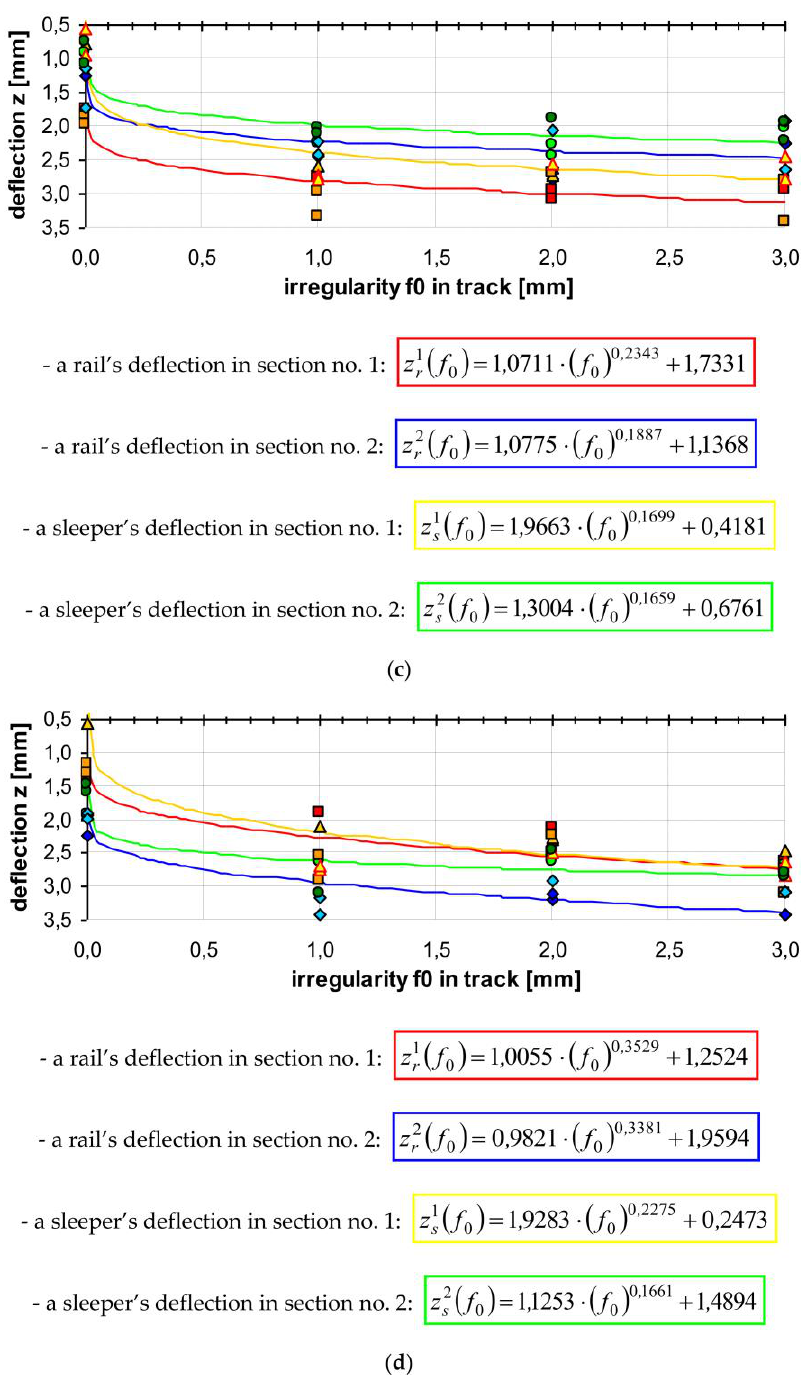
Figure 8. A deflection of the rail and sleeper due to induced irregularity in the railway track (axle load no. 3 and no. 4 of the locomotive): ( a ) axle load no. 3 in section no. 1 – 3 axle (R 2 = 0.839); ( b ) axle load no. 3 in section no. 2 – 3 axle (R 2 = 0.926); ( c ) axle load no. 4 in section no. 1 – 4 axle (R 2 = 0.885);